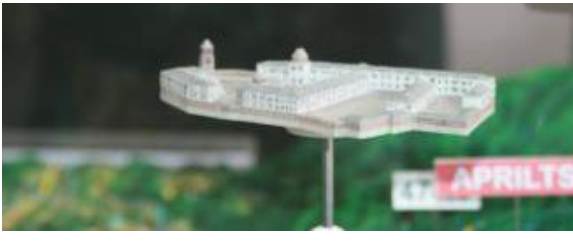
Figure 6. 3D printed model of Troyan Monastery.